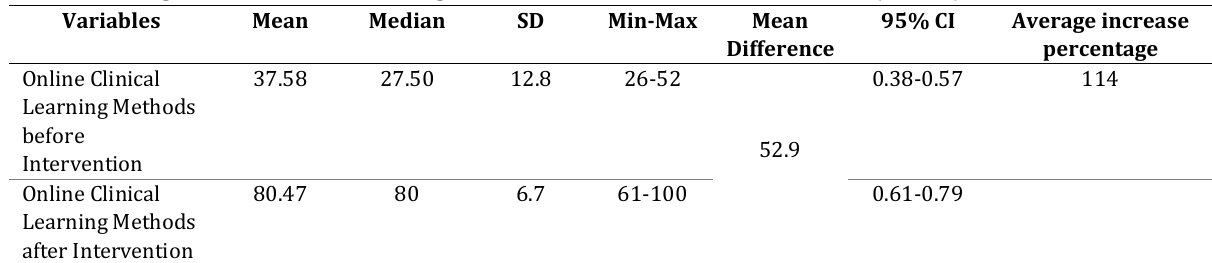
Table 3. Average Online Clinical Learning Methods Before and After Intervention (N=110) Variables